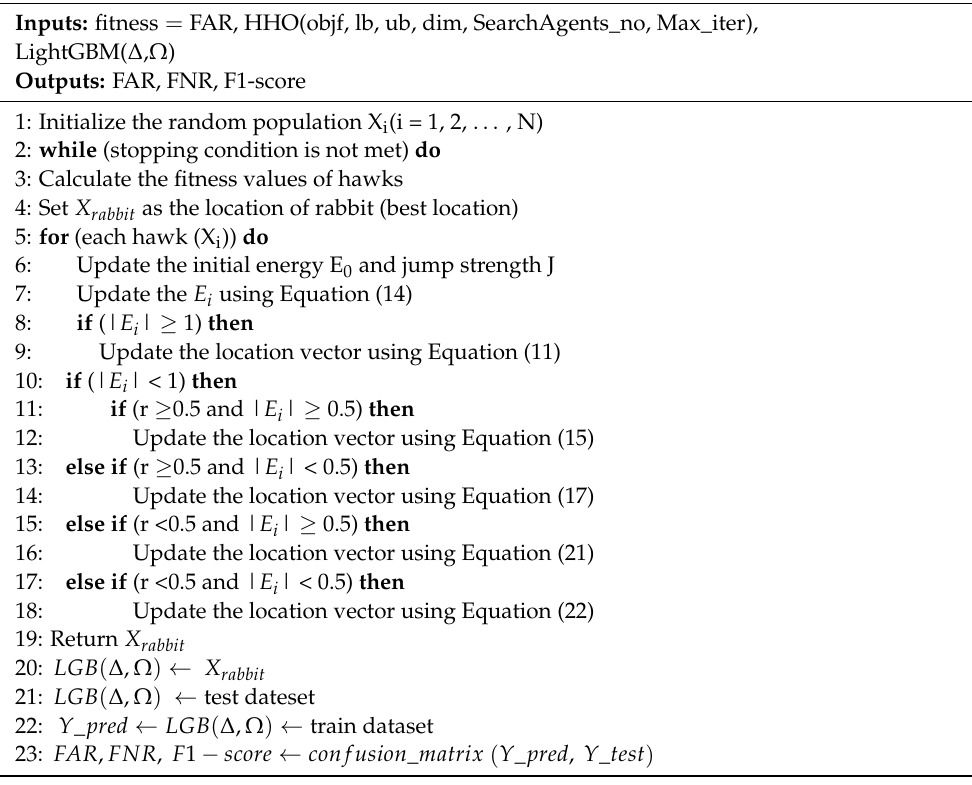
Algorithm 1 IHHO-LightGBM algorithm